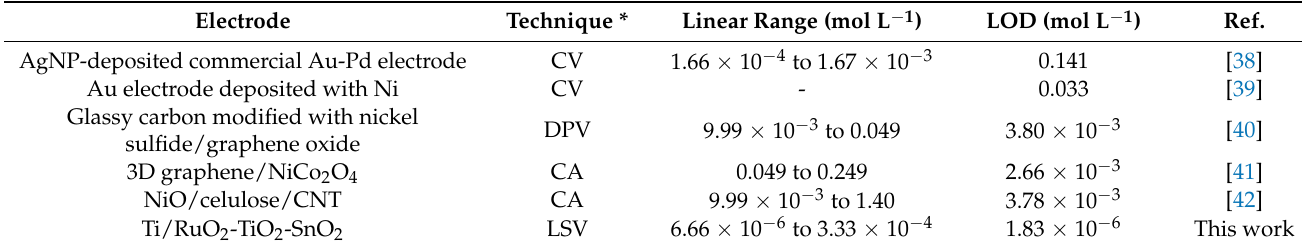
Table 5. Comparison between performance characteristics of the proposed method and other studies described in the literature for urea determination.